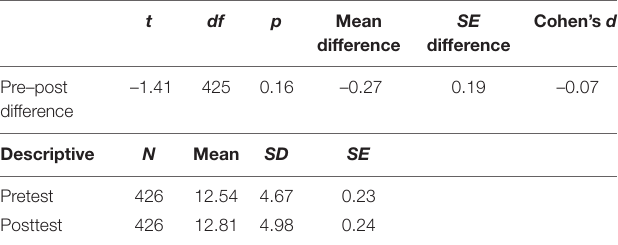
TABLE 5 | Student STEM reasoning